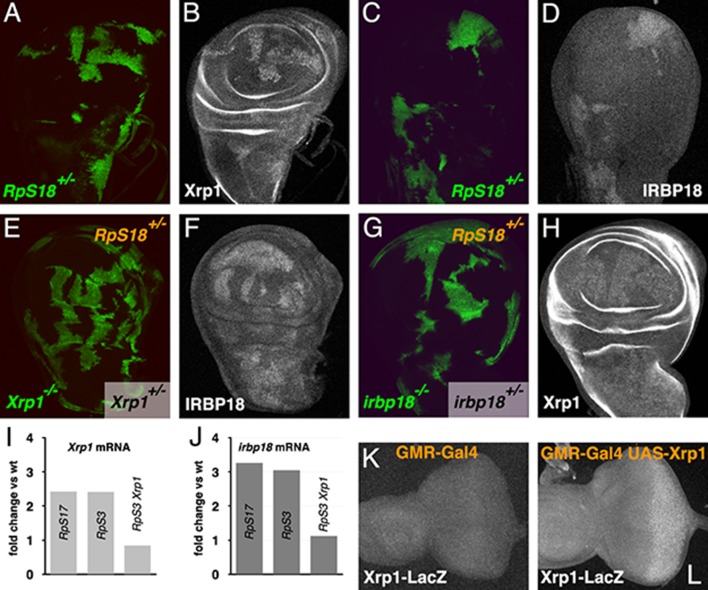
Cross-regulation of Xrp1 and IRBP18 expression.(A,B) Xrp1 protein (labeled in B) is elevated in RpS18+/- cells (green in A) compared to RpS18+/+ cells (unlabelled in A). (C,D) Irbp18 protein (labeled in D) is elevated in RpS18+/- cells (green in C) compared to RpS18+/+ cells (unlabelled in C). (E,F) Irbp18 protein (labeled in F) is elevated in RpS18+/-Xrp1+/- cells or RpS18+/-Xrp1+/+ cells (unlabelled in E) compared to RpS18+/-Xrp1-/- cells (green in E), showing that Irbp18 protein expression is Xrp1-dependent. (G,H) Xrp1 protein (labeled in H) is higher in RpS18+/-irbp18+/- and RpS18+/-irbp18+/+ cells (both unlabeled in G) than in RpS18+/-irbp18-/- cells (green in G), showing that Xrp1 protein up-regulation is Irbp18-dependent. (I) mRNA fold-change in wing imaginal discs of various genotypes in comparison to wild type controls. Both Xrp1 and irbp18 mRNA levels were elevated in Rp+/- wing discs in an Xrp1-dependent manner. Fold changes compared to wild type were determined using DESEQ2 from three biological replicates (Lee et al., 2018). The adjusted probabilities that expression levels differed from the wild type control were 7.95 × 10−153 (Xrp1 in RpS17+/-), 1.21 × 10−146 (Xrp1 in RpS3+/-), 0.0149 (Xrp1 in RpS3+/-Xrp1+/-), 6.75 × 10−32 (irbp18 in RpS17+/-), 9.72 × 10−34 (irbp18 in RpS3+/-), 0.714 (irbp18 in RpS13+/-RpS3+/-Xrp1+/-). (K,L) Over-expression of Xrp1 in the posterior eye disc under control of GMR-Gal4 (L) upregulates the Xrp1-LacZ enhancer trap compared to the GMR-Gal4 control (K), confirming transcriptional auto-regulation. Genotypes A-D) y w hs-FLP; FRT42D ubi-GFP M(2)56F/FRT42. E,F) y w hs-FLP; tubP-GAL4 UAS-mCD8::GFP/FRT42D ubi-GFP M(2)56F; FRT82B Xrp1M2-73/FRT82B tubP-GAL80. G,H) y w hs-FLP; tubP-GAL4 UAS-mCD8::GFP/FRT42D ubi-GFP M(2)56 f*; irbp18f05006 FRT80B/tubP-GAL80 FRT80B. K) GMR-Gal4/+; Xrp102515/+. L) GMR-Gal4/UAS-Xrp1; Xrp102515/+.